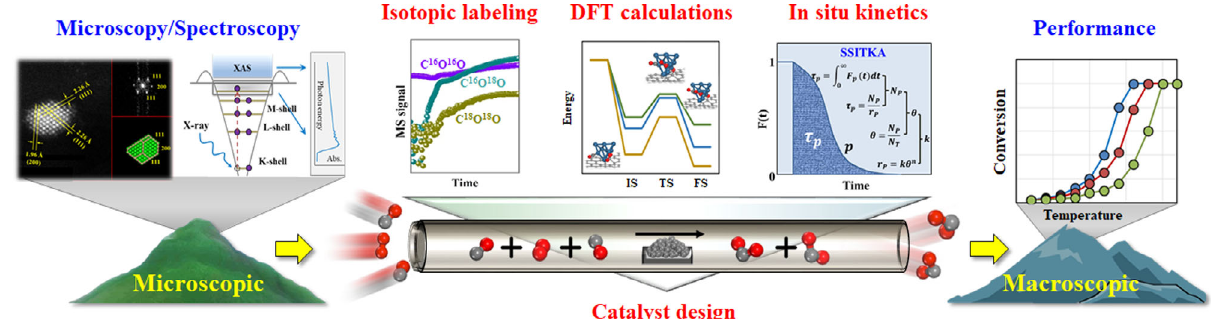
Fig. 1 Strategy to bridge the microscopic-to-macroscopic transition. Schematic diagram of bridging the upscaling gap between the microscopic fi ngerprints of active sites and the macroscopic catalytic performance based on (in situ) spectroscopy/microscopy characterization, isotopic labeling technique, DFT calculations and in situ kinetics measurements for CO oxidation.